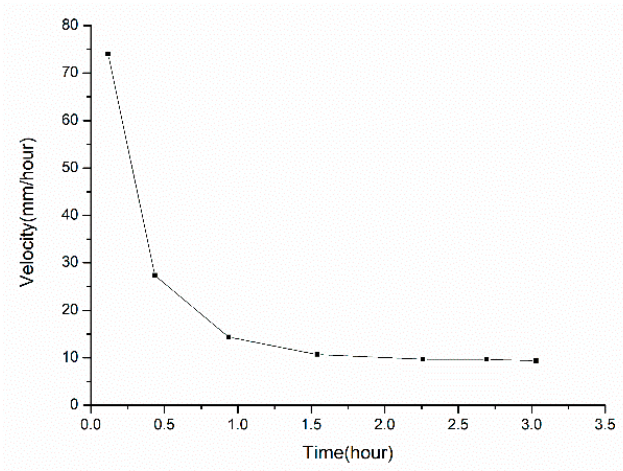
Figure 10. Imbibition velocity of the fracturing fluid versus time for core 96.